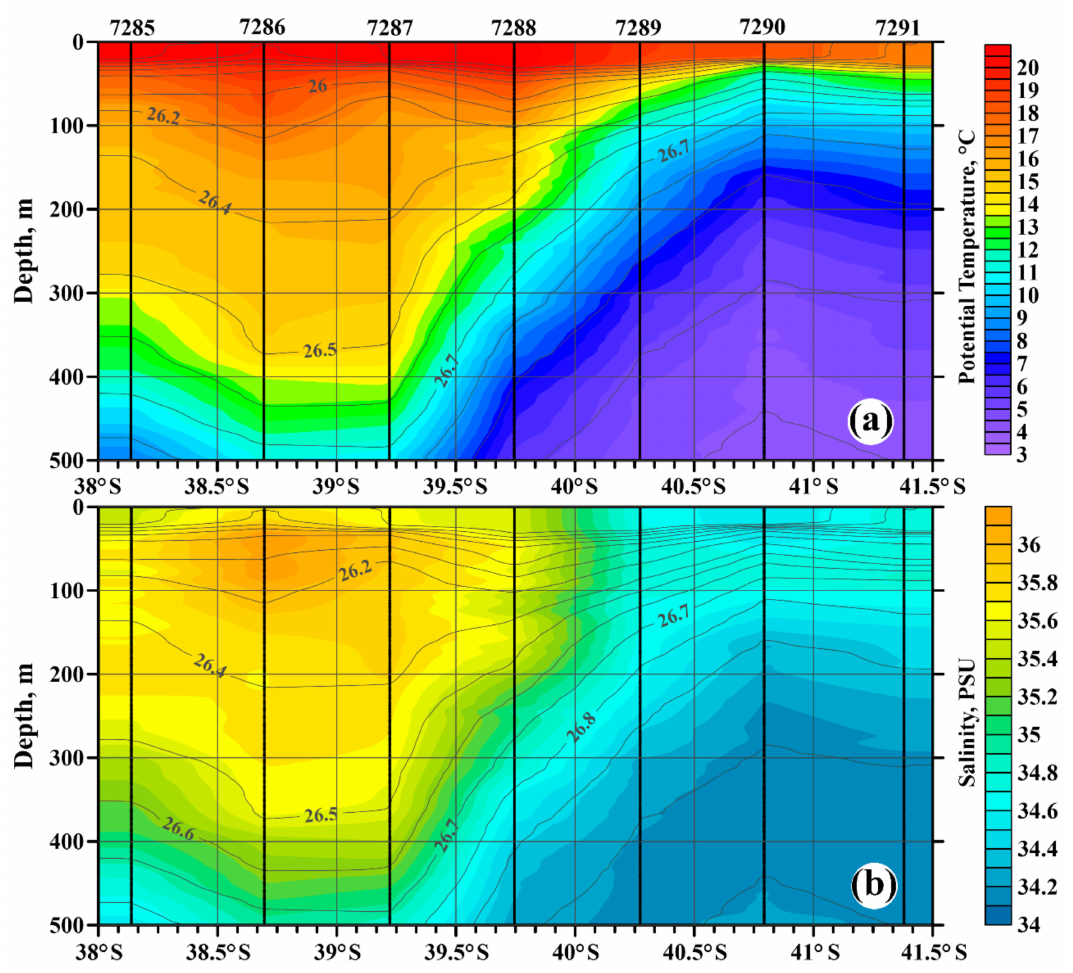
Figure 3. Sections of potential temperature ( a ) and salinity ( b ) across the rings based on CTD measurements. Isolines of potential density anomalies are shown by solid lines. Locations of stations are shown by thick black